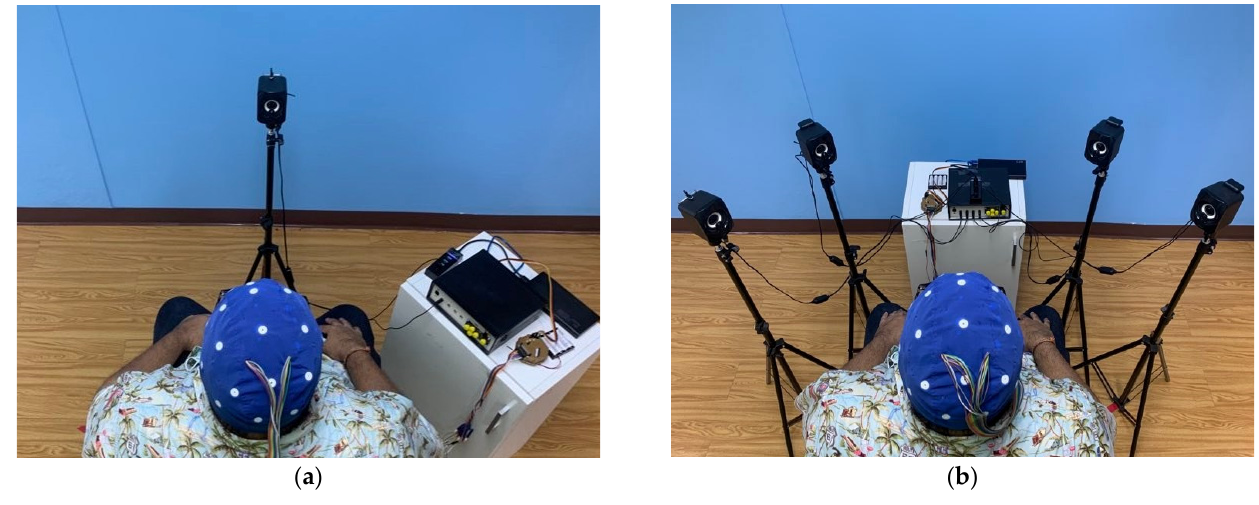
Figure 4. Experimental setup of the auditory stimuli evoked EEG potentials. ( a ) Auditory stimulus with a single loudspeaker. ( b ) Auditory stimulus with multi loudspeakers.